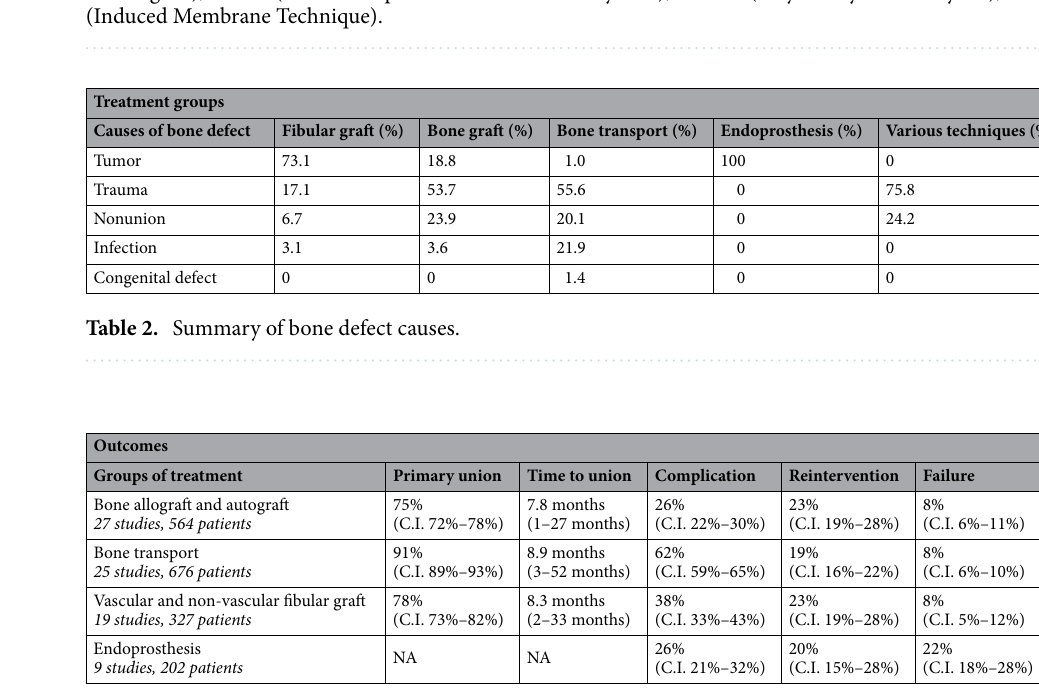
Table 3. Summary of all